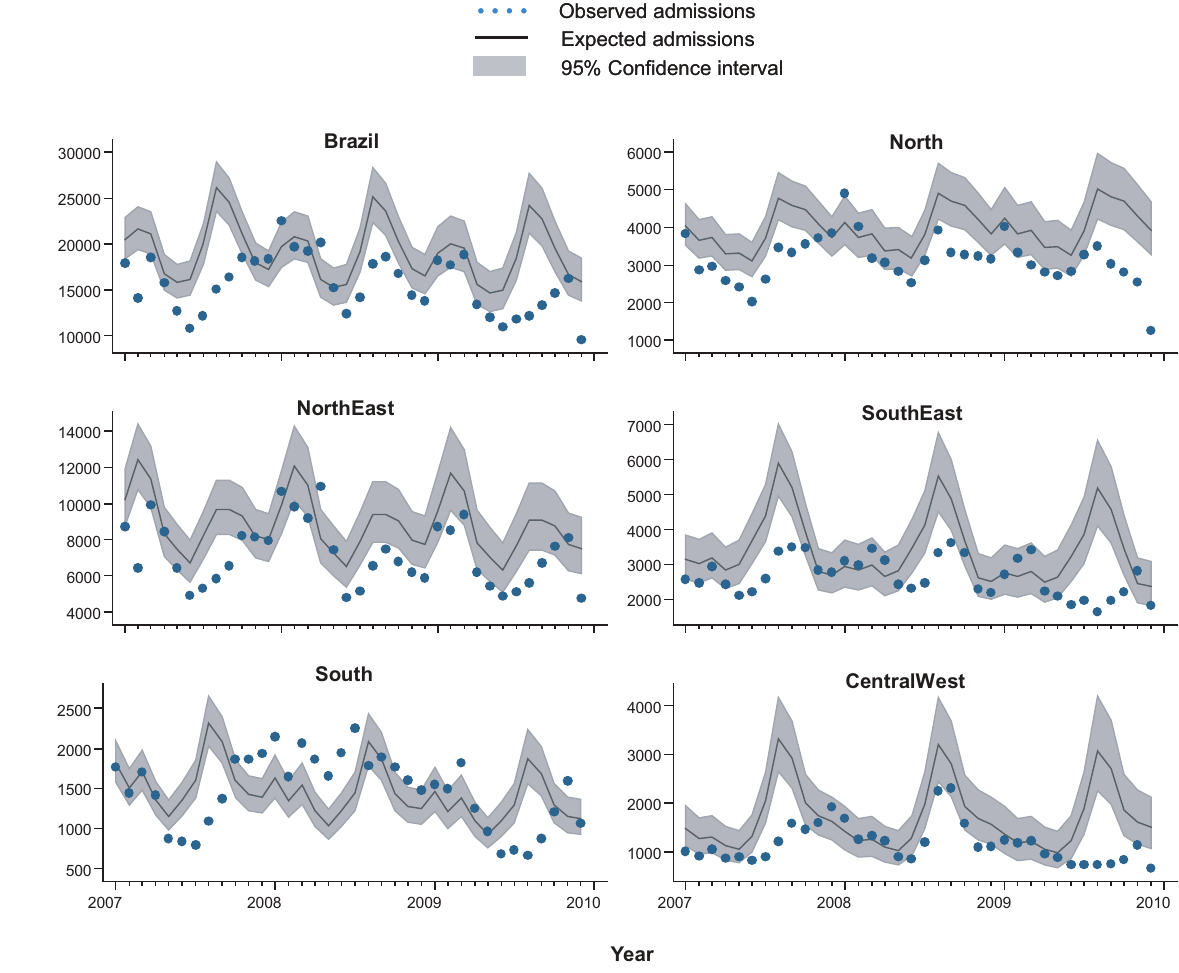
Figure 4. Impact of rotavirus vaccination on monthly events of diarrhea admissions in Brazil by region. Each analysis compares the monthly observed events among children under 5 y after rotavirus vaccination (2007 to 2009) with expected events in the absence of vaccination, by region. Expected number of events and 95% CIs are based on predictions from regression models fitted to historic data from each region (2002 to